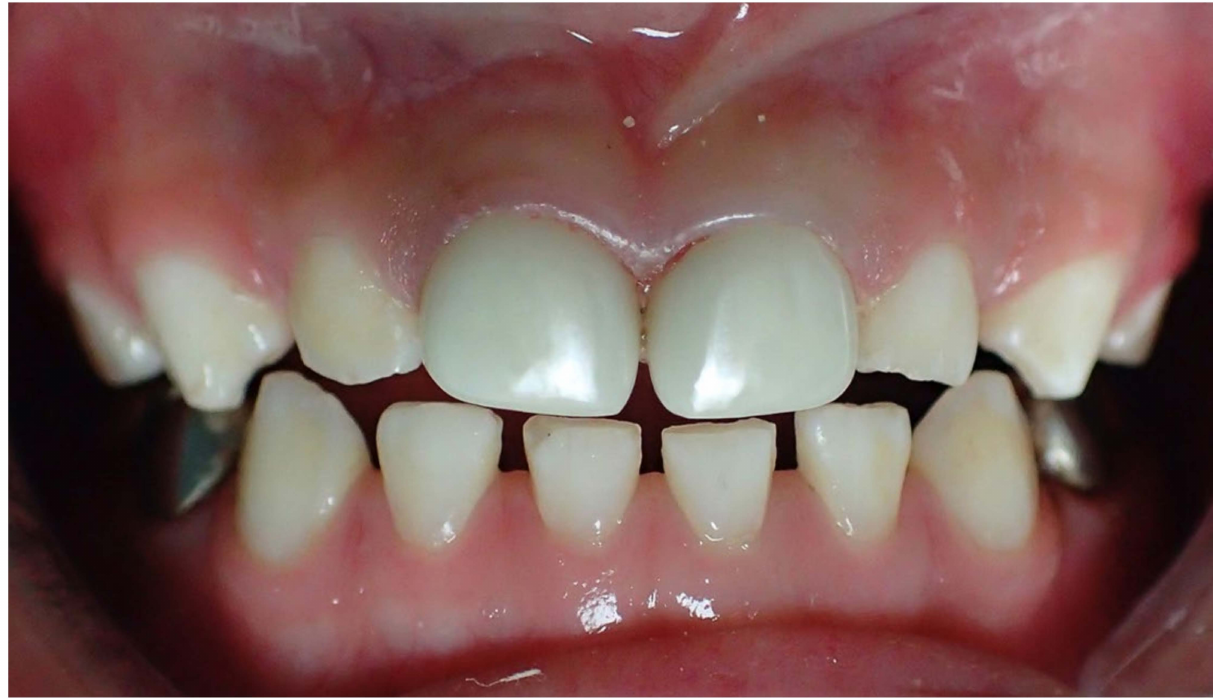
Figure 2. Restoration of two anterior teeth. Parents rated tooth 51 and 61 colour match as “no noticeable difference from other teeth”. Crown contour was “nicely contoured and natural looking”. Dentists rated colour match as “slight shade match” and crown contour as “not aesthetic, detracts from the appearance of